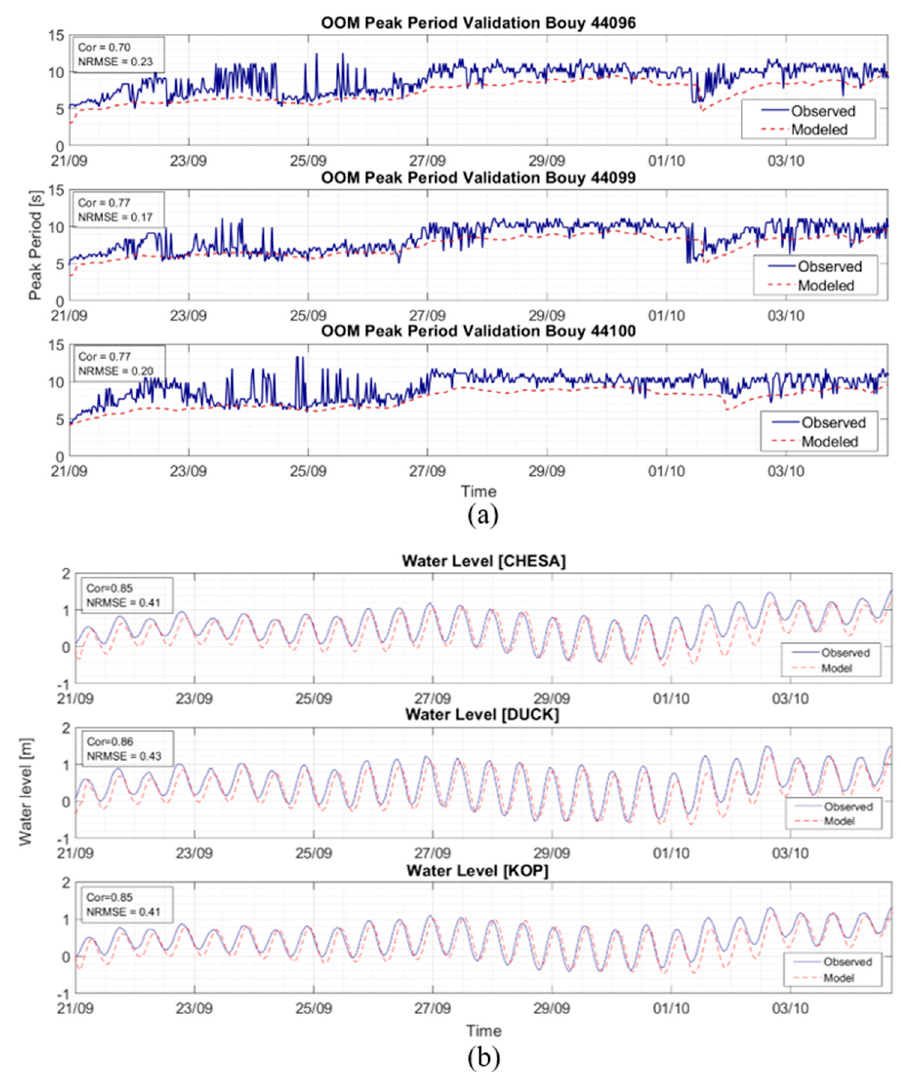
Figure 6. Comparison between the observed (blue) and model (red) results. The legend on the left indicates correlation coefficient (Cor) and normalized root mean square error (NRMSE): ( a ) Comparison between the peak periods (Tp); and ( b ) Comparison between the water levels.